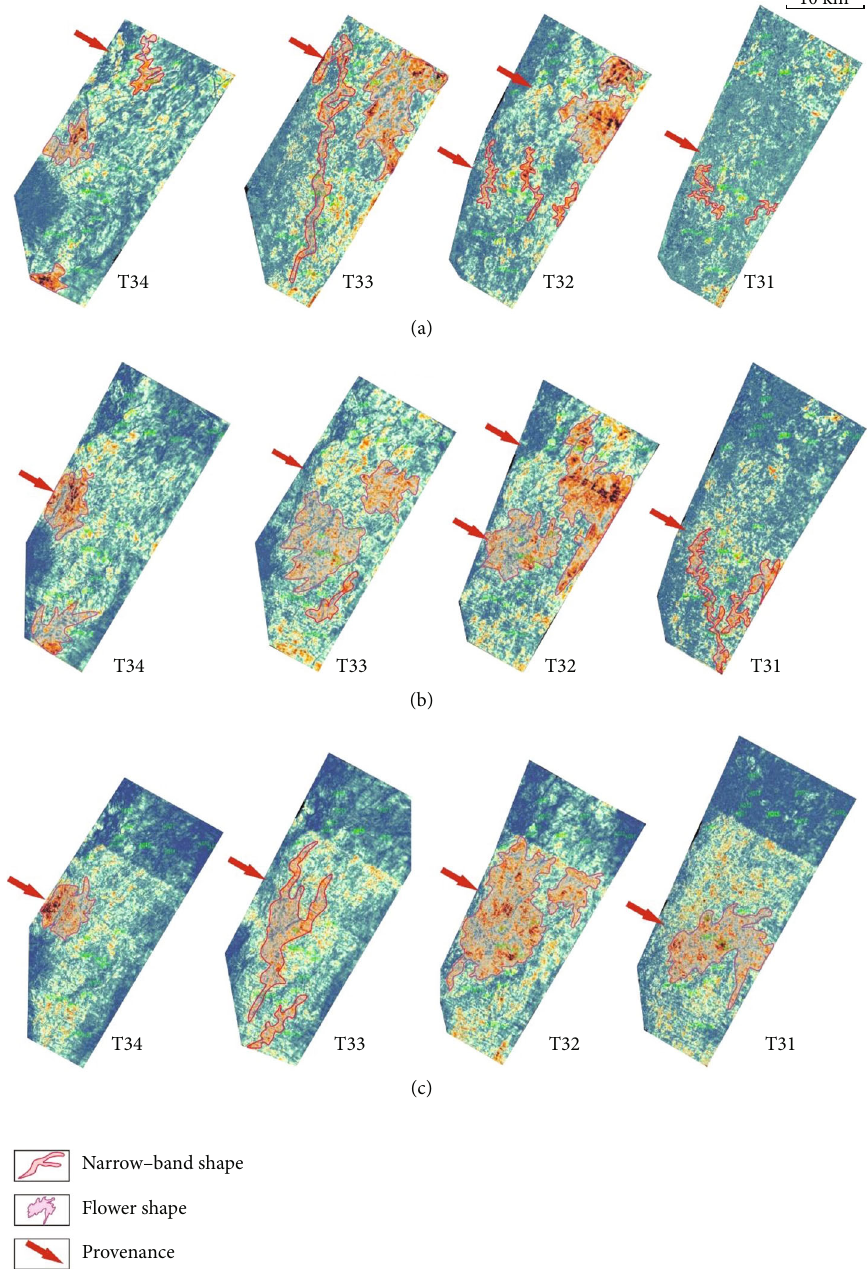
Figure 6: Shape distribution of strong earthquake amplitudes corresponding to sand bodies with di ff erent